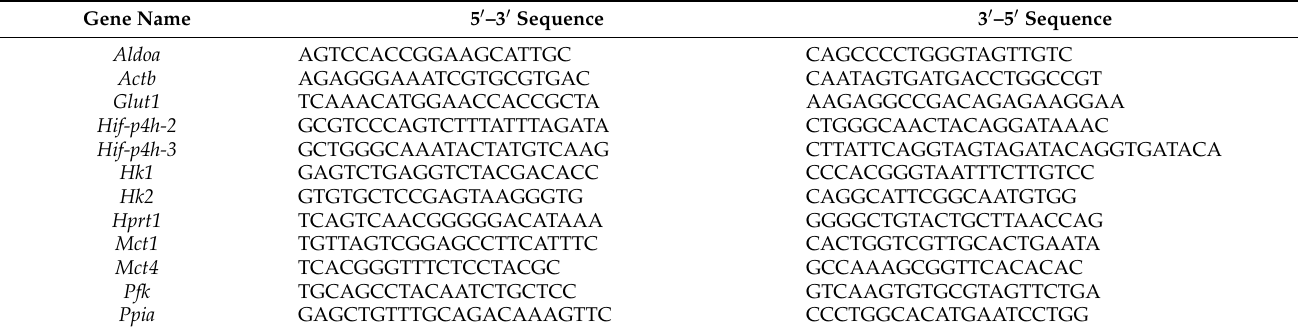
Table 1. Primers for